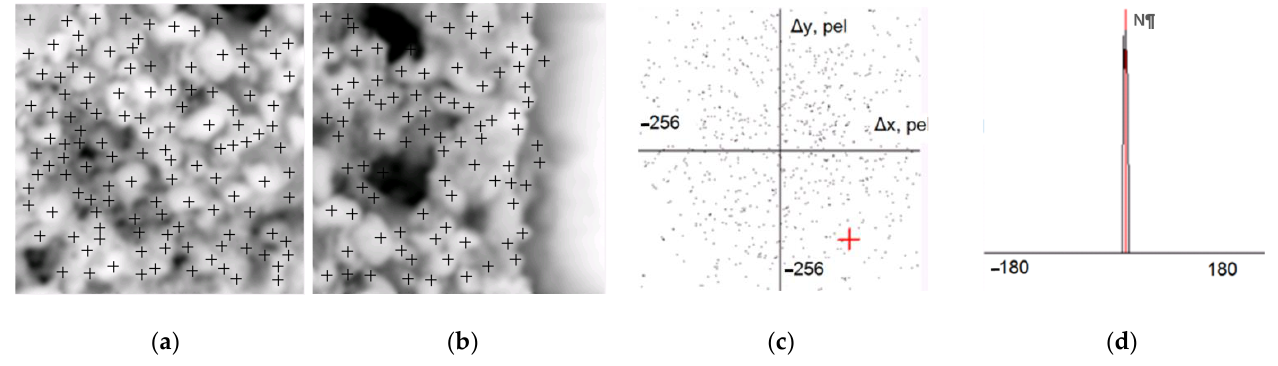
Figure 9. Results obtained by the IMBKPP method for fullerene-containing powder images: ( a , b ) source images with marked particle centres; ( c ) the map of displacement values; ( d ) the rotation angle histogram.